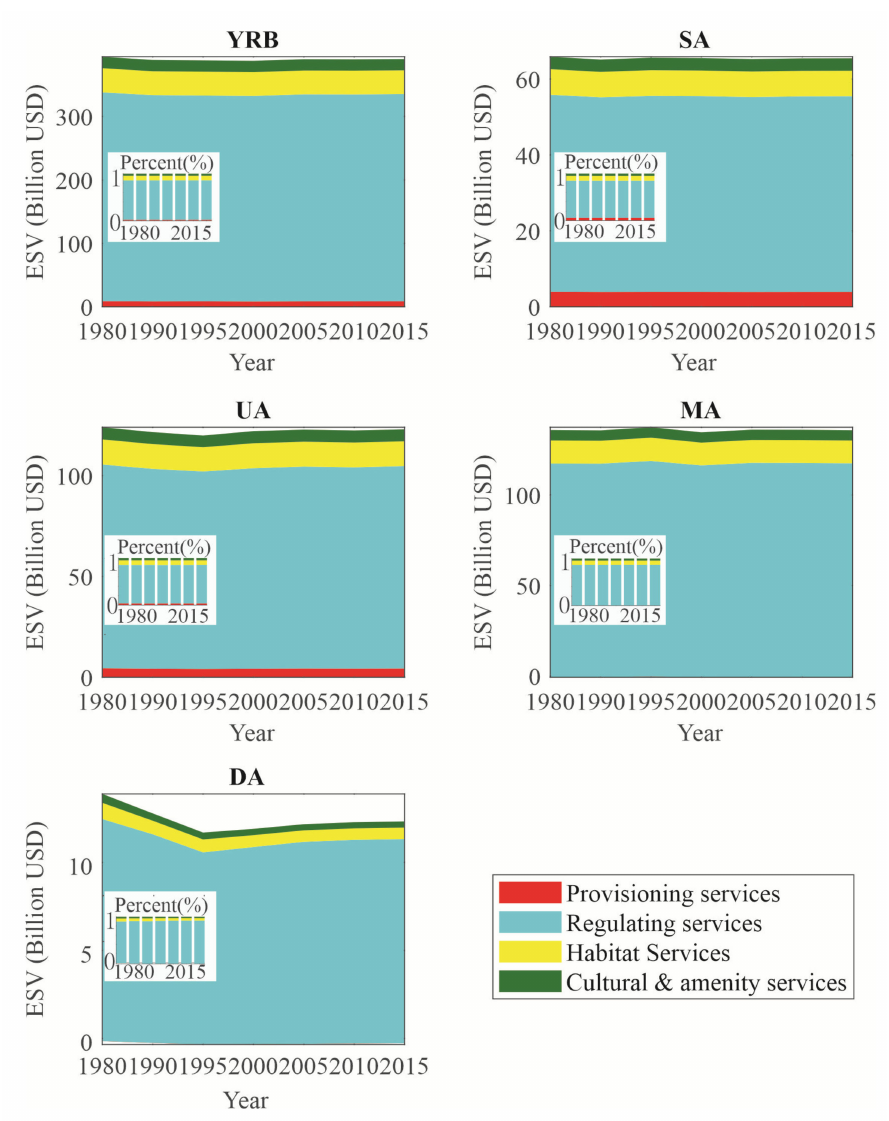
Figure 4. ESV of YRB, SA, UA, MA, and DA from 1980 to 2015. The sub-figure describes the proportion of each ES